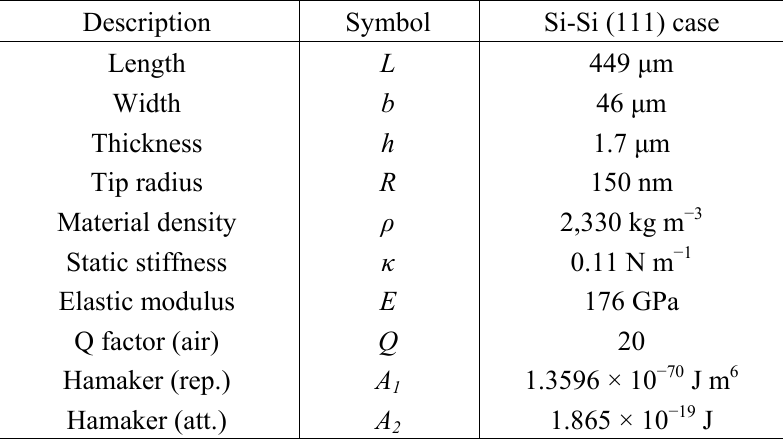
Table 1. Material properties of